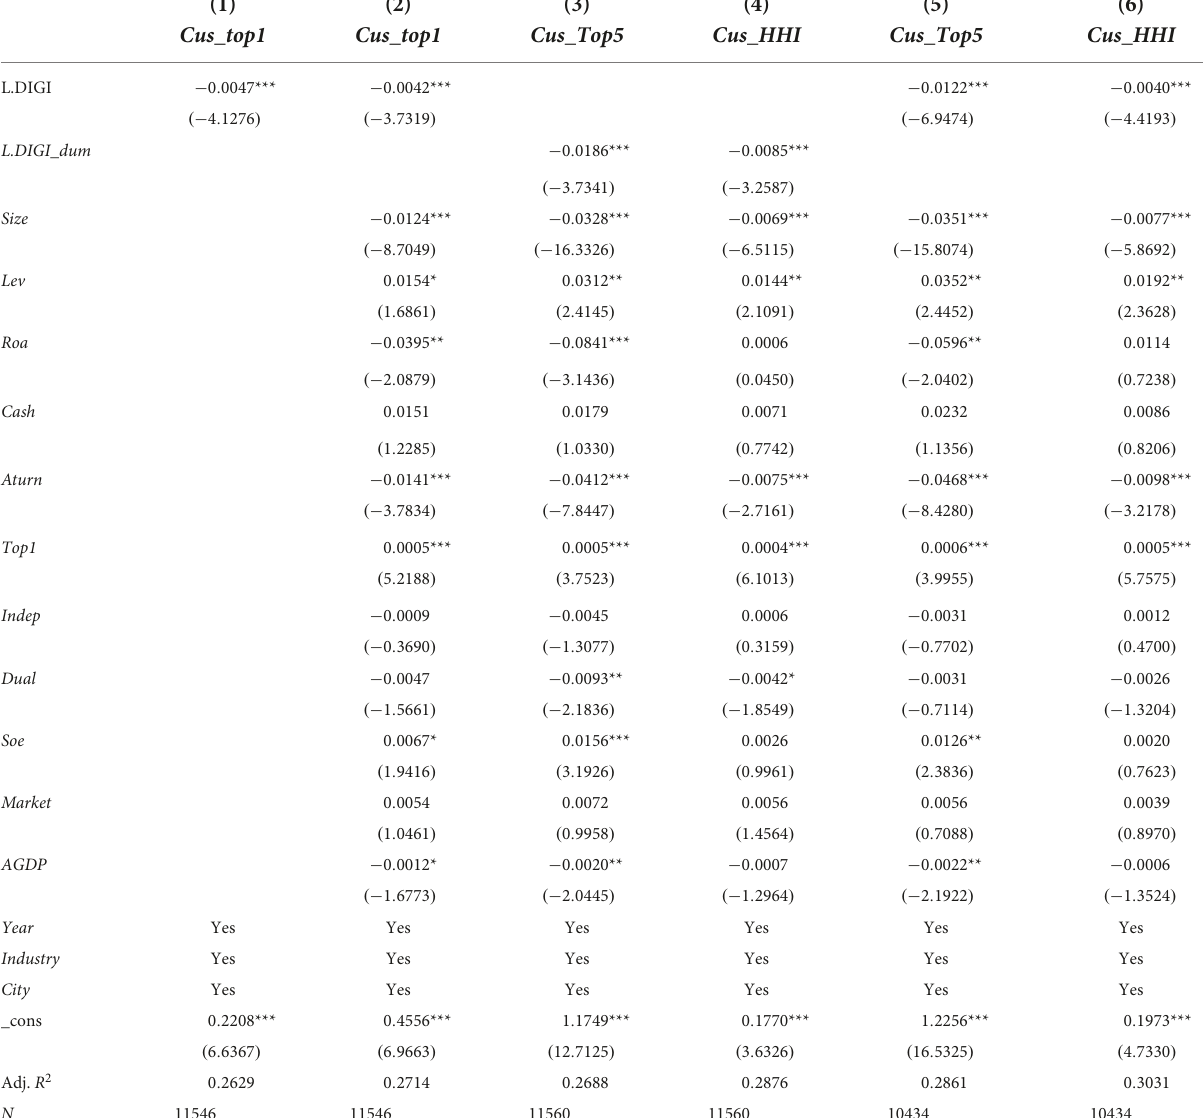
TABLE 6 Robustness test.